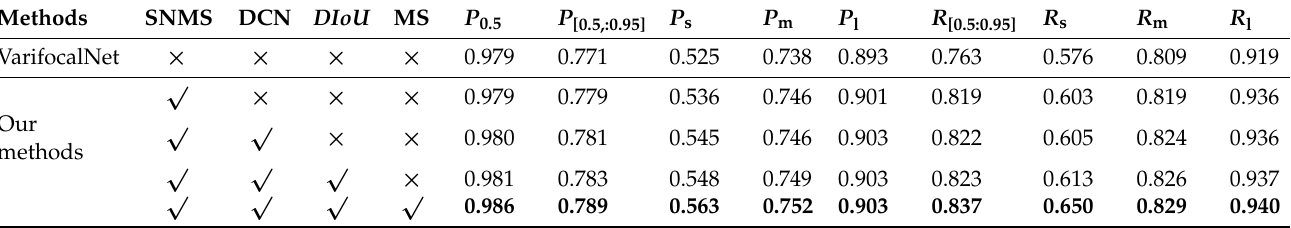
Table 2. Combine experiment of four improved method, including soft non-maximum suppression (SNMS), deformable convolutional networks (DCN), distance-intersection over union ( DIoU ), and multi-scale (MS).